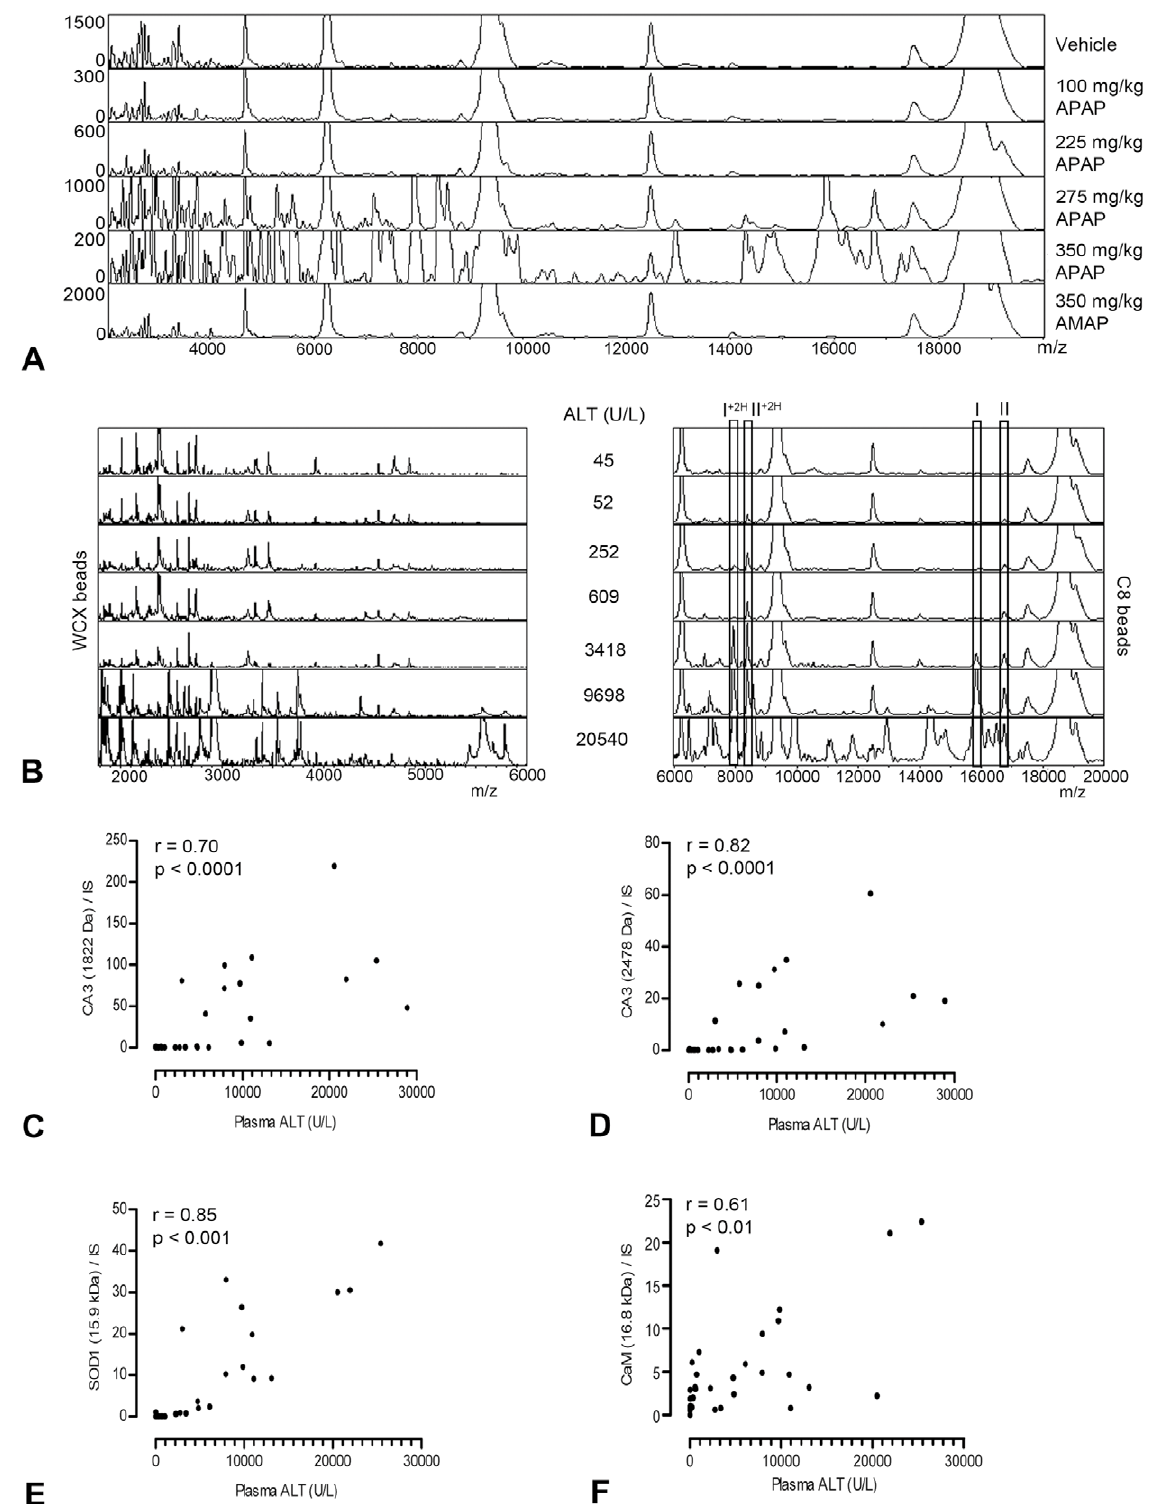
Figure 2. Urinary protein profiles of APAP-induced liver injury in mice. Representative urine protein profiles of m/z values versus peak intensity illustrate an APAP dose-related increase in urinary protein excretion (A). ALT-dependent increases in protein peaks were observed in urine samples pretreated with WCX beads or C8 beads (B). The protein masses of 15.9 kDa and 16.8 kDa are indicated by (I) and (II), respectively. Double charged forms are indicated by ( + 2H). The correlation between the relative peak intensity of two representative urinary CA3 fragments (C & D), SOD1 (E), and CaM (F) and plasma ALT was determined using the Spearman’s rank correlation coefficient (r) in mice with APAP dose $ 275 mg/kg body weight. ALT: alanine aminotransferase; APAP: acetaminophen; CA3: carbonic anhydrase 3; CaM: calmodulin; SOD1: superoxide dismutase 1; WCX: weak cation exchange. doi:10.1371/journal.pone.0049524.g002 PLOS ONE | www.plosone.org